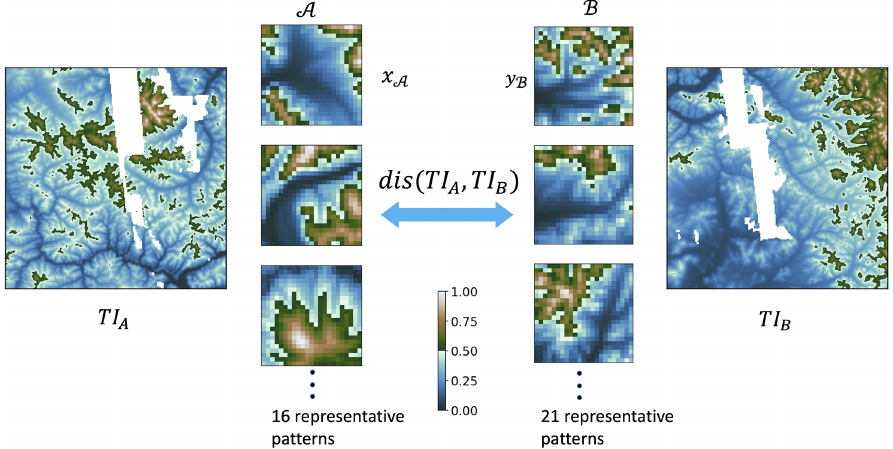
Figure 4. Calculating the distance between any two training images (TI A and TI B ) using modified Hausdorff distance. There are three key steps. (1) The first is to extract training patterns with a fixed template. (2) The representatives are selected by a hierarchical clustering method. In this example, the method found 16 important patterns from TI A , and 21 patterns are from TI B . The number of representatives is dependent on the complexity of morphology. (3) The third step is to calculate the modified Hausdorff distance between two pattern sets. The output distance becomes an indicator of similarity between two